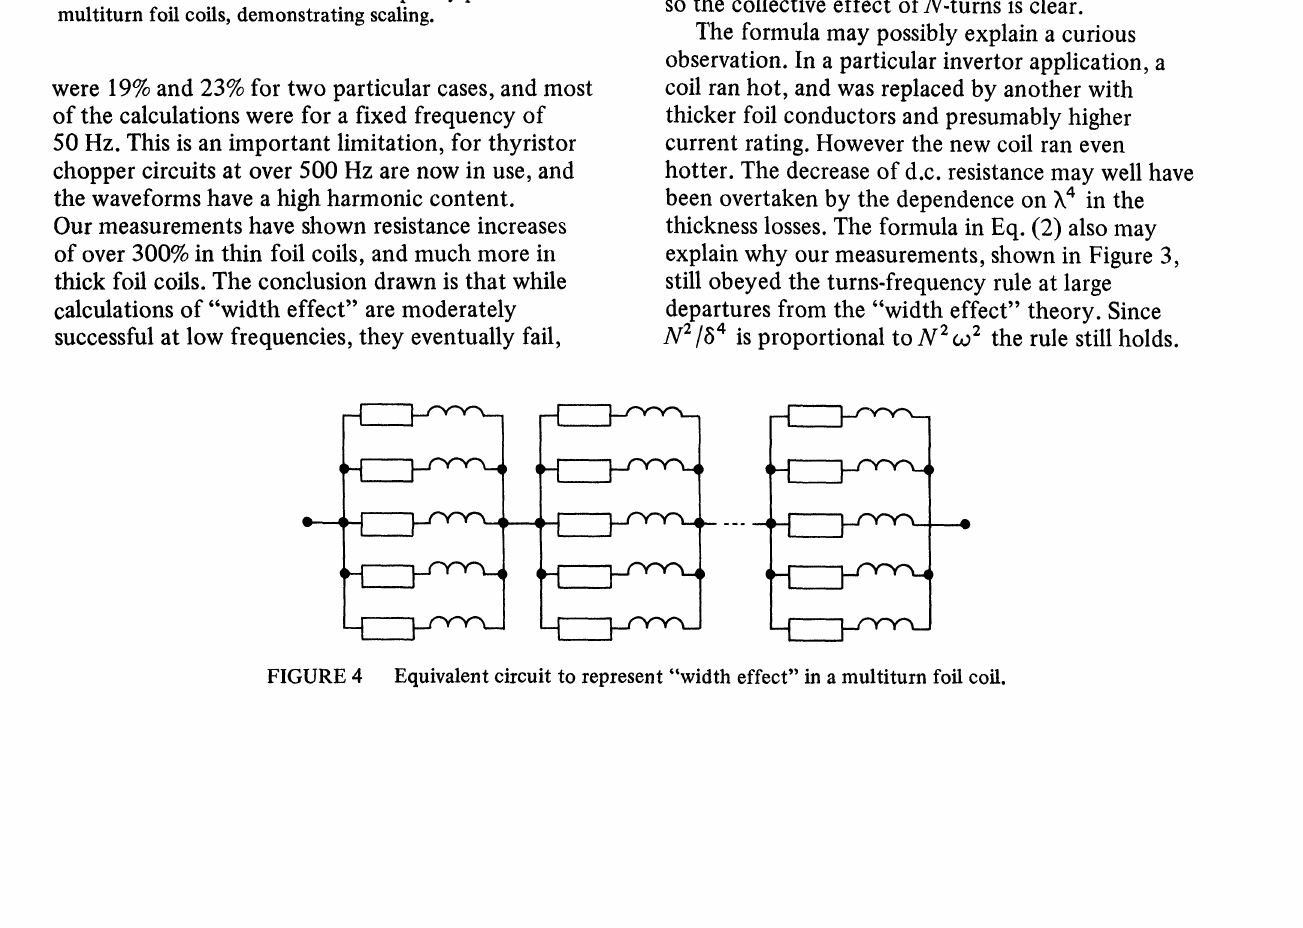
Resistance vs. Turns-frequency product in multiturn foil coils, demonstrating scaling.